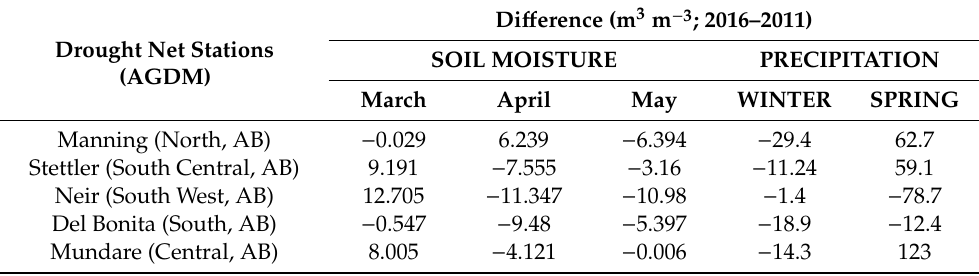
Table 3. Di ff erence between 2016 and 2011 of observed soil moisture (first 5 cm) in volume % in Alberta (AB).